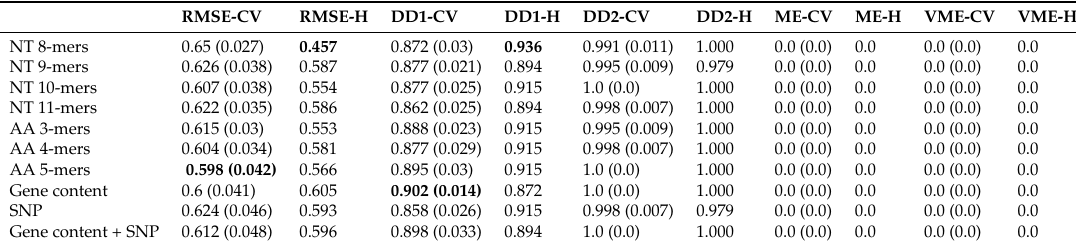
Table A12. C. jejuni –erythromycin.